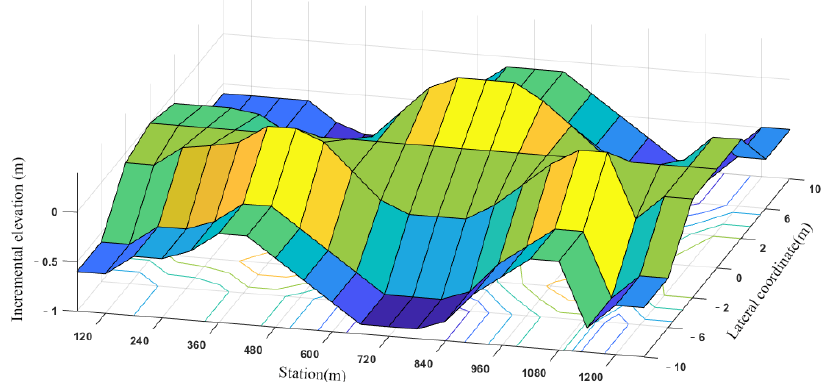
Figure 17. Schematic diagram of the change in road topography height.